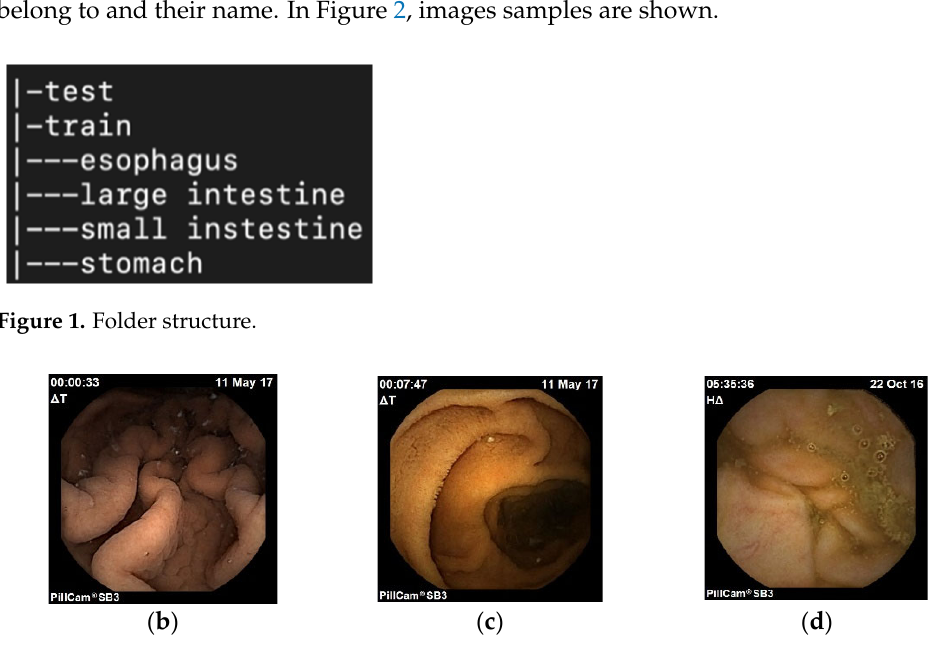
Figure 2. Images of esophagus ( a ), stomach ( b ), small intestine ( c ) and colon ( d